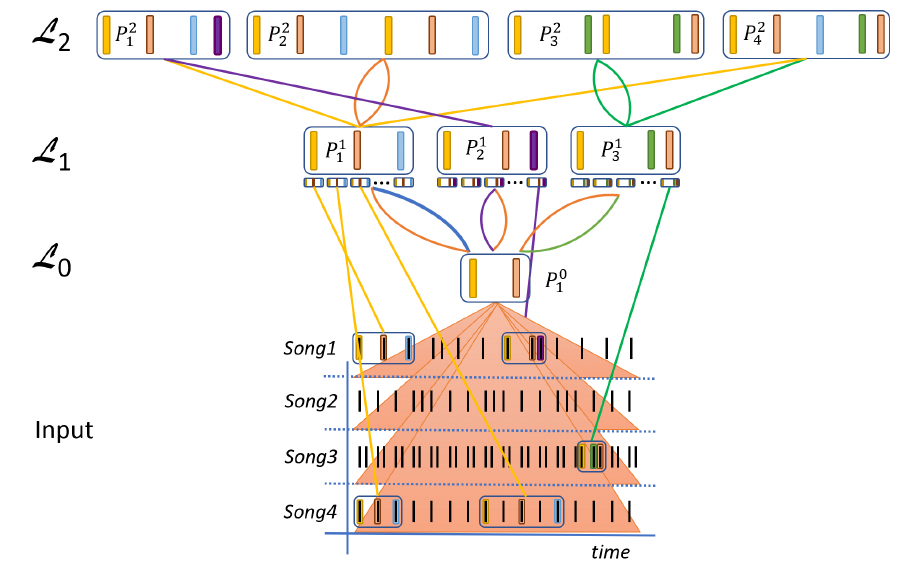
Figure 2. An abstract representation of a learned rhythmic hierarchy. Each layer consists of a set of parts which are compositions of parts from the previous layer. For each part, we display the rhythmic pattern it encodes, while the connections between parts show how compositions are formed. The compositions are formed of (sub)parts, where the second subpart is encoded relatively to the first part in the composition. The part on the first layer P 0 represents any occurrence of two input events. 1 As the encoding of parts is time-invariant, parts activate wherever the patterns they encode occur in the input, regardless of their scaling. To illustrate this, we show three activations of the part P 1 with three 1 different time scales in the input. Altogether, only five L 1 activations are shown, others are omitted for